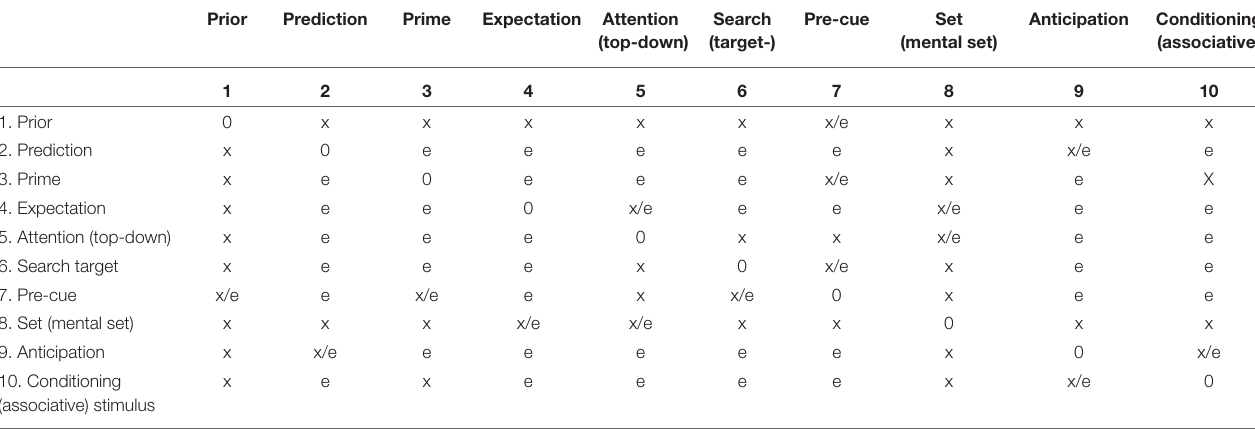
TABLE 1 | A set of interrelated concepts referring to the hypothetical effects of prior processed information on processing of the subsequently presented information for its perception. Prior Prediction Prime Expectation Attention